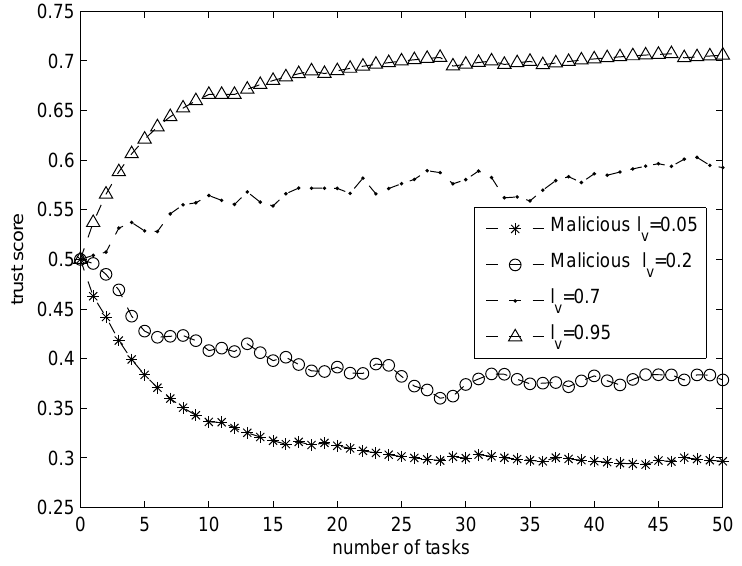
Figure 4. Trust score comparison between honest platoon member vehicles with l v = 0.7, l v = 0.95 and malicious PM vehicles with l v = 0.05, l v =